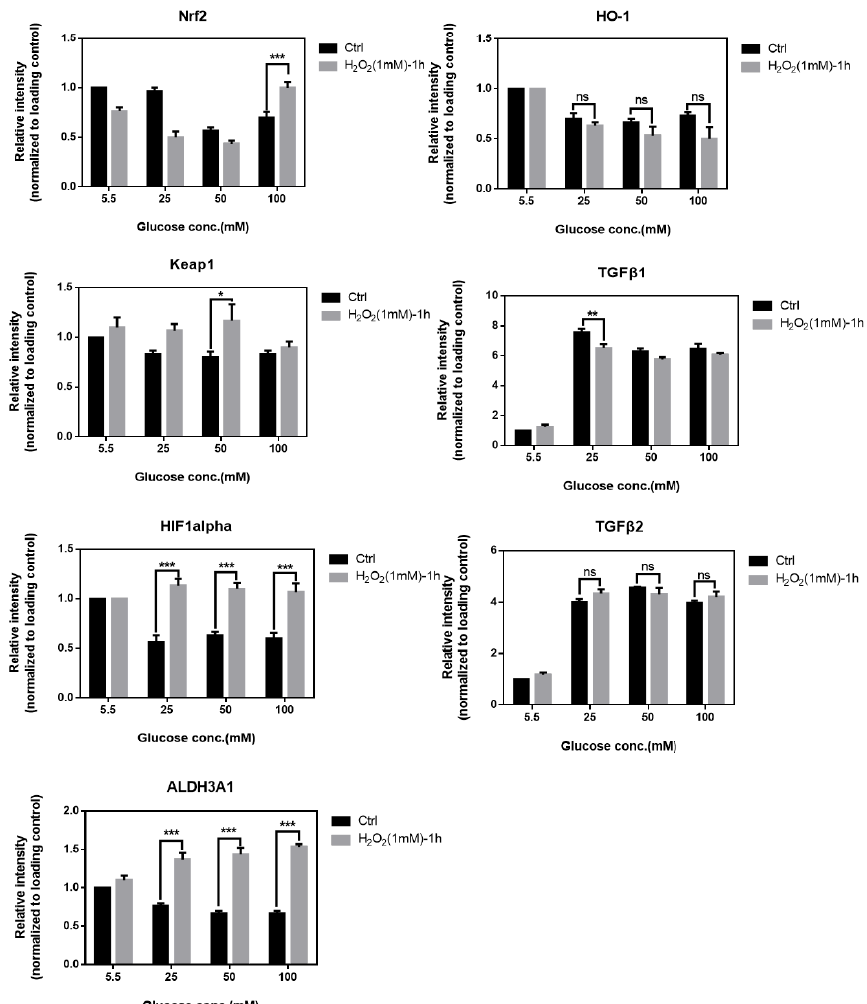
Figure 9. Immunoblot analysis in RGCs with hyperglycemia with or w / o hydrogen peroxide (1 mM) for 1 h. Immunoblot analysis of antioxidation pathway-associated proteins (Nrf2, Keap1, HIF-1 α , ALDH3A1, HO-1, TGF β -1, and TGF β -2) in 5.5 mM, 25 mM, 50 mM, and 100 mM glucose supplemented medium with or w / o hydrogen peroxide (1 mM) for 1 h. The protein expression values were quantified in relation to the loading control. Data are represented as means ± SEM. *, p < 0.05; **, p < 0.01; ***, p < 0.001; ns, non-significant when compared to the 5.5 mM group ( n = 3).